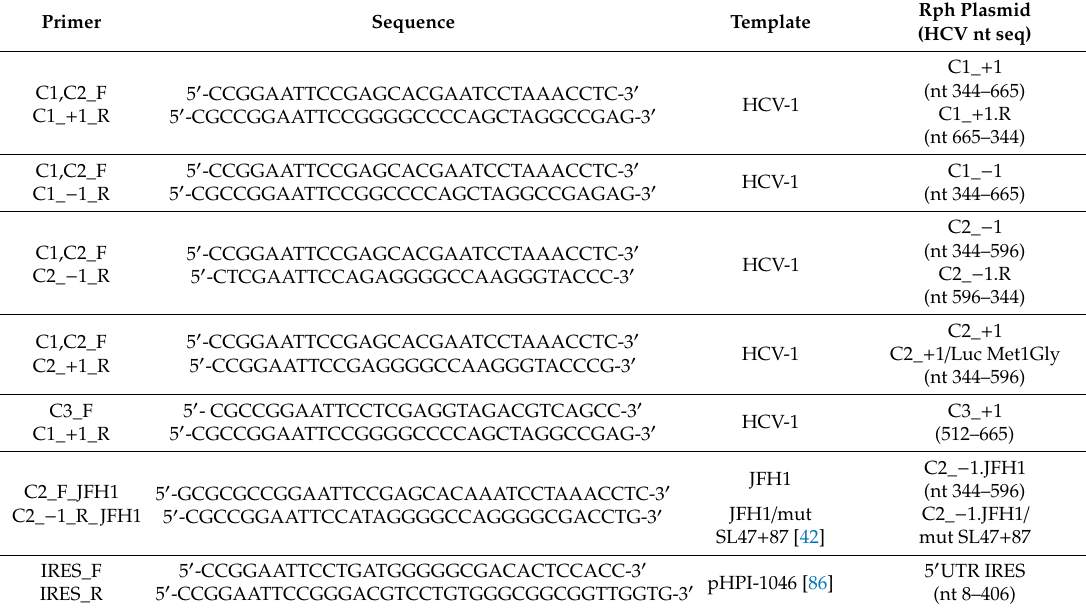
Table 1. List of priming specific oligonucleotides used for Rph plasmid